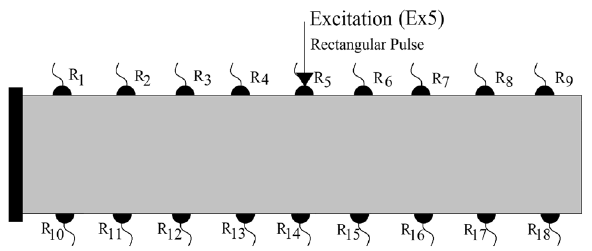
Figure 7. The defined excitation source and receiver sensors on a 2D cantilever beam.